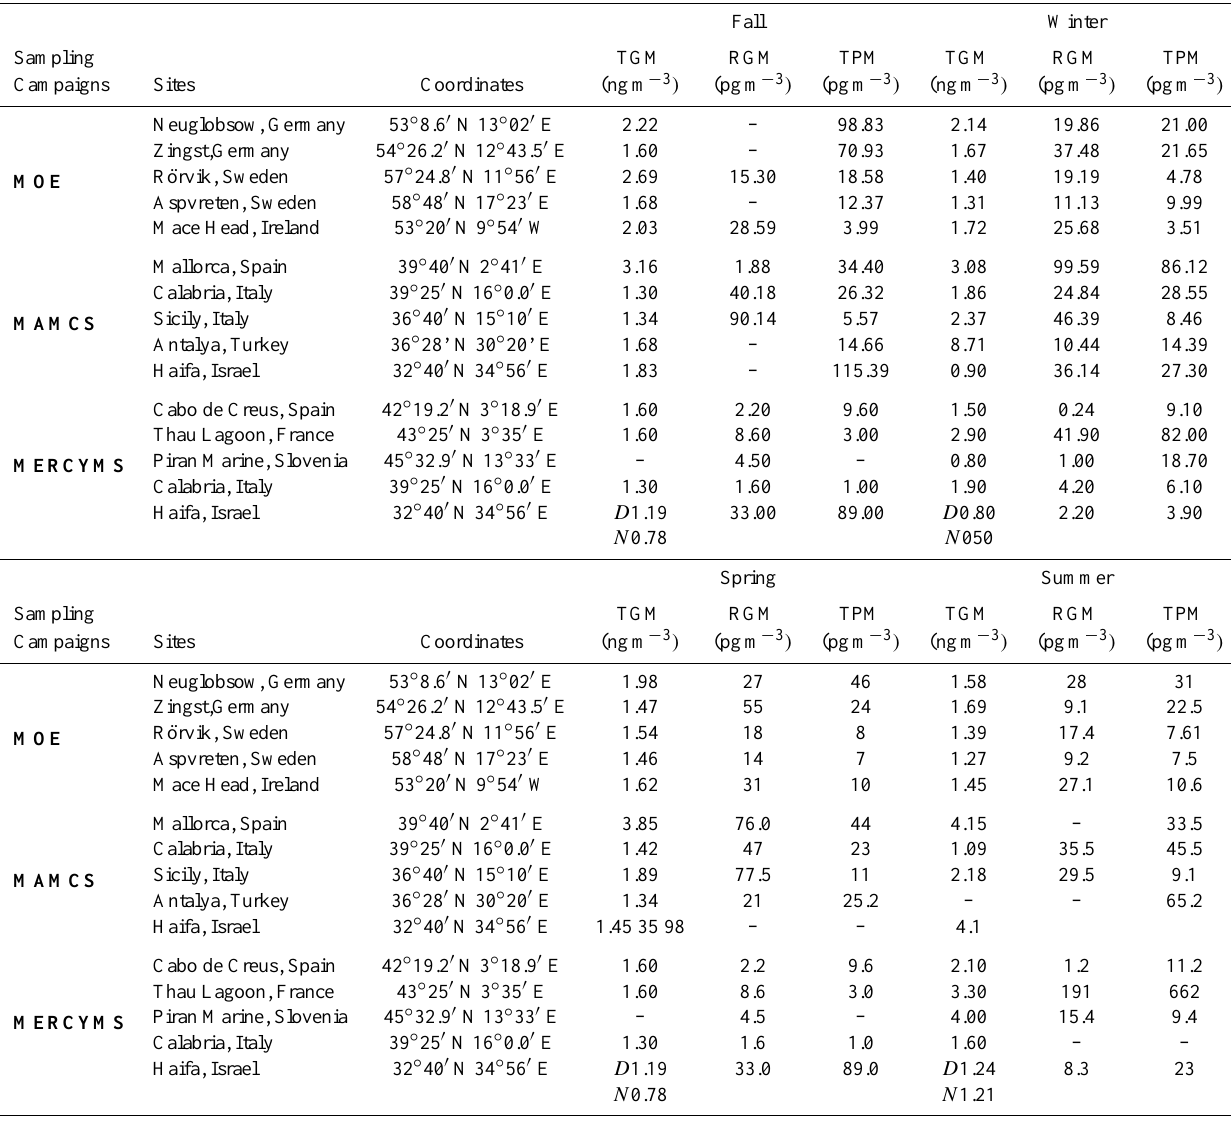
Table 1. TGM, RGM and TPM average values observed at the selected coastal sites in the Mediterranean during the four seasonal campaigns of the MOE, MAMCS and MERCYMS projects. D : Day; N :